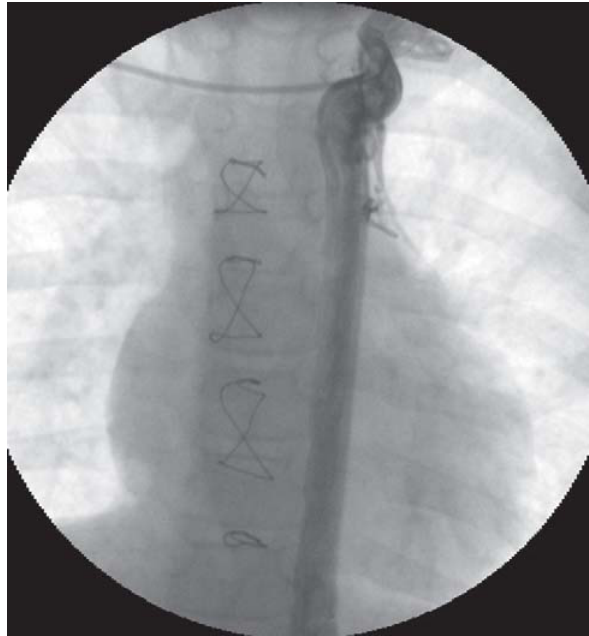
Fig. 5 – Cateter na veia inominada contrastando a veia hemiázigo com fluxo retrógrado em direção ao sistema da veia cava inferior